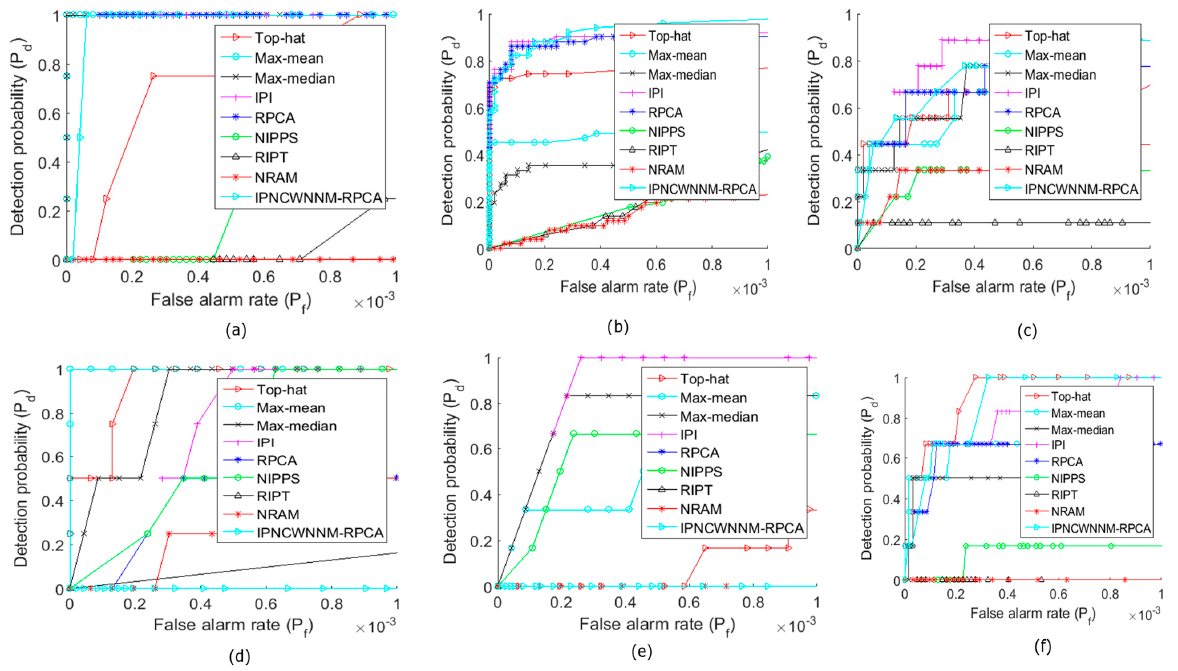
Figure 10. ( a – f ) are the ROC curves of the six image sequences from Figure 8a. Compared with the existing baseline approaches, the suggested method not only suppresses the strong clutter background but detects the small target better. The different SCRG values for the image sequences from the six state-of-the-art approaches and the suggested method are shown in Table 6.